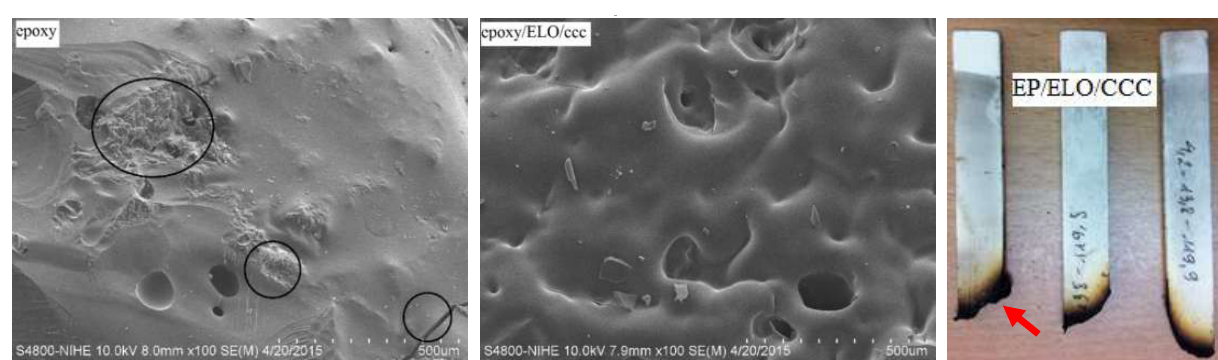
FIG. 12. FE-SEM IMAGES OF THE RESIDUA OF EPOXY/ELO/CCC COMPOSITES (CCC: SB